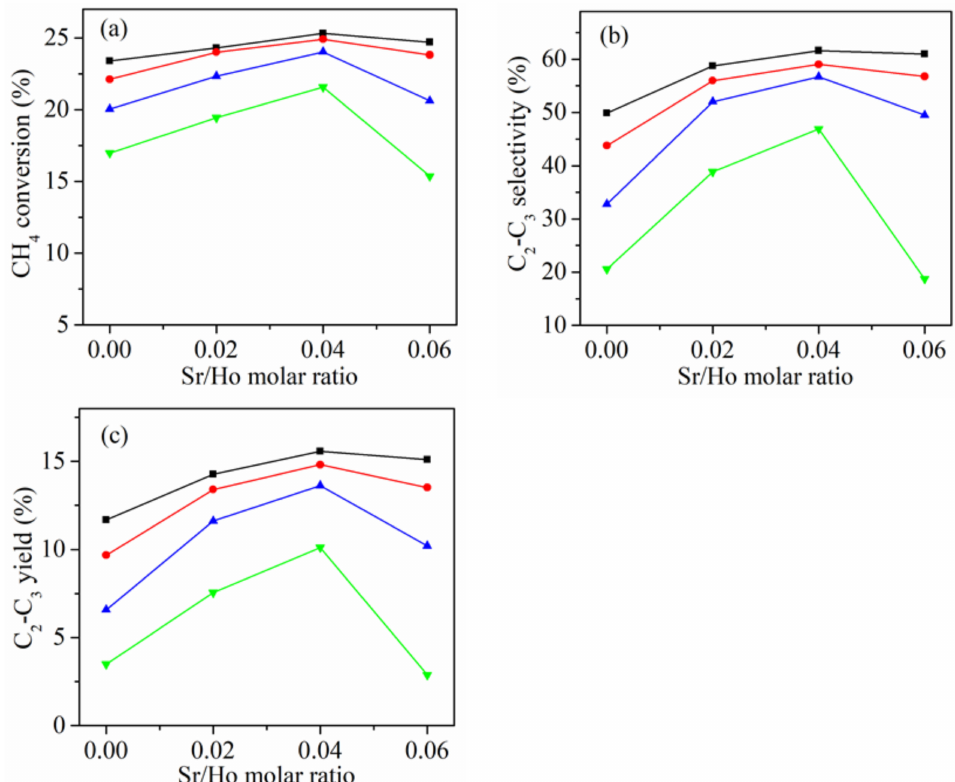
Figure 2. Effect of Sr/Ho molar ratio on catalytic performances of Sr-modified Ho 2 O 3 nanosheet (Sr-Ho 2 O 3 -NS) catalysts at different temperatures: ( a ) CH 4 conversion, ( b ) C 2 -C 3 selectivity, and ( c ) C 2 -C 3 yield. ( (cid:72) ) 600 ◦ C, ( (cid:78) ) 650 ◦ C, ( • ) 700 ◦ C, ( (cid:4) ) 750 ◦